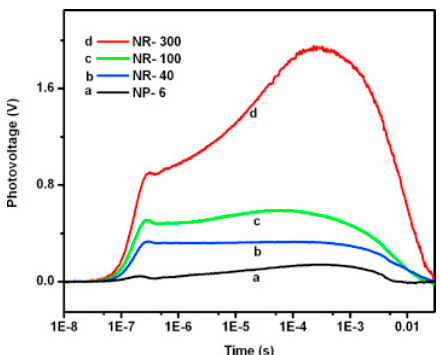
Figure 31. Responses of the NP-6, NR-40, NR-100, and NR-300 samples towards formaldehyde without UV light irradiation. Reproduced with permission from [13].